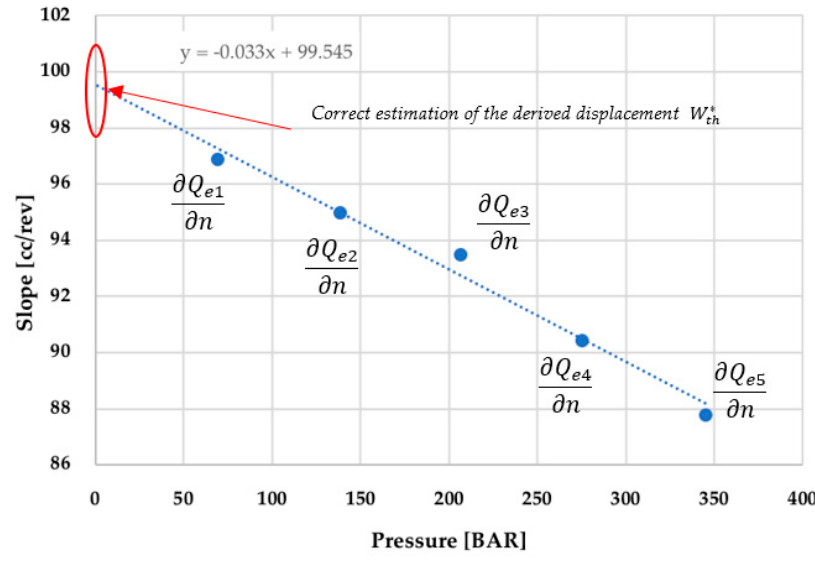
Figure 3. Second step for estimating the derived displacement using this method.